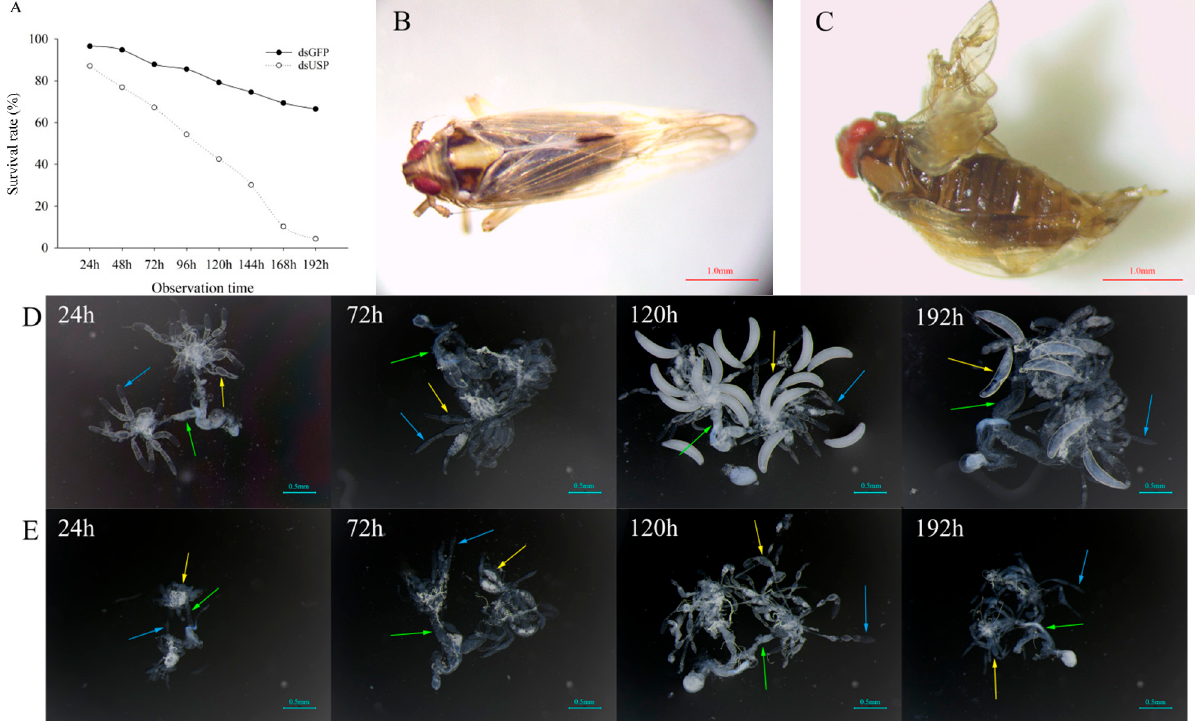
Figure 4. Phenotype of S. furcifera after RNAi. ( A ) Survival rate of S. furcifera . ( B , C ) Female adult development of S. furcifera after GFP -RNAi and USP -RNAi. ( D , E ) Ovarian phenotype of female adult S. furcifera after GFP -RNAi and USP -RNAi. Note: The time in the upper left corner represents the time of collection after adults. Blue arrows indicate the ovaries. Yellow arrow indicates the oocytes. Green arrow indicates the fallopian tubes.